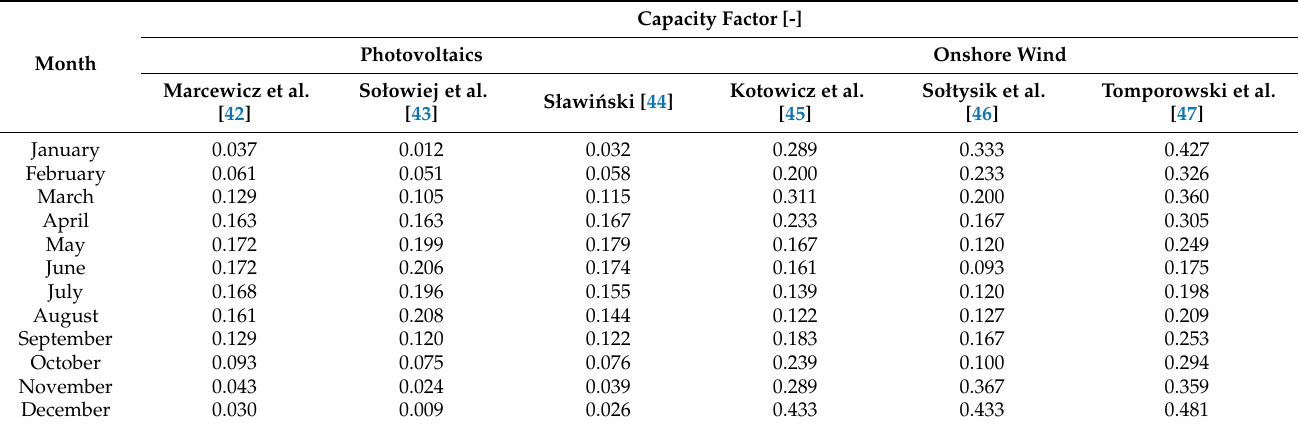
Table 3. Generation in photovoltaic sources and onshore wind sources.